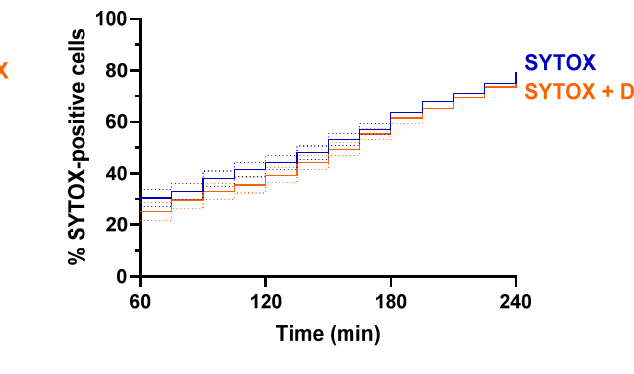
Figure 4. Comparison of % fluorescently positive single yeast cells upon treatment with HsAFP1 evaluated by DHE and SYTOX. Yeast cells were treated with 100 µ g/mL HsAFP1 during 3 h on chip, resulting in 4 h of total treatment at room temperature using DHE and/or SYTOX to evaluate ROS induction or membrane permeabilization. Images were taken every 15 min. The percentages of fluorescent cells when using DHE ( A ) or SYTOX ( B ) alone (blue) as compared to using both DHE and SYTOX together (orange). A minimum of 521 cells was evaluated for every independent biological experiment; 3 independent biological experiments were included ( n = 3). Significant differences were determined using a likelihood ratio test on the Cox proportional hazards regression for survival data ( α = 0.05). Dotted lines represent asymmetrical 95% confidence intervals. No significant differences could be observed.